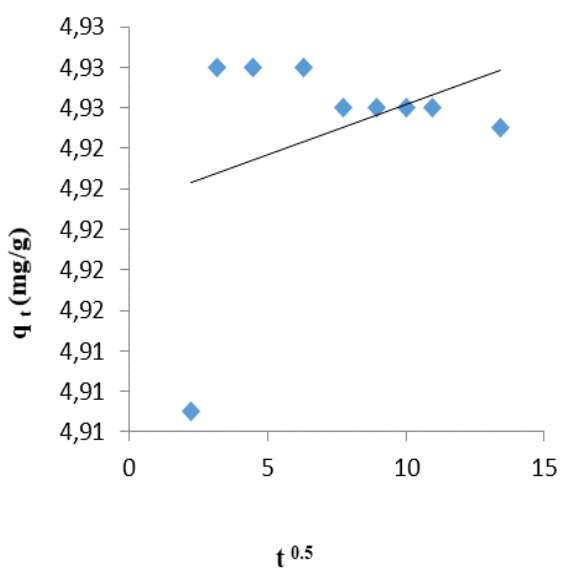
Fig. 9. Intra- particle diffusion kinetic modeling of Cd 2+ adsorption onto SEZ at initial concentration 10 mg/L (25 ± 0.2 °C)